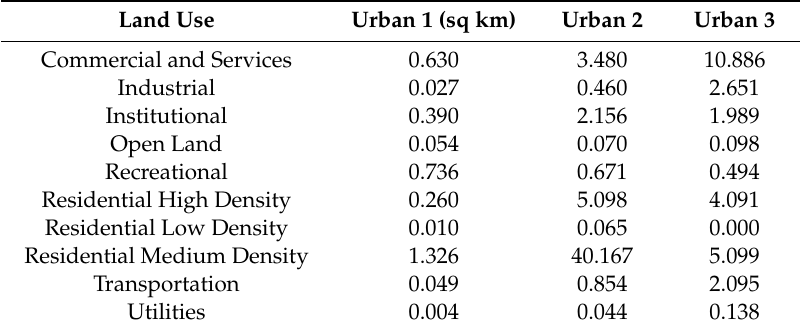
Table 8 . Area statistics for SVM classification of NDCCI/NBI/BAEI composite derived from 10/22/16 Table 8. Area statistics for SVM classification of NDCCI / NBI / BAEI composite derived from 22 October Landsat 8 OLI data, referencing FDEP data. 2016 Landsat 8 OLI data, referencing FDEP